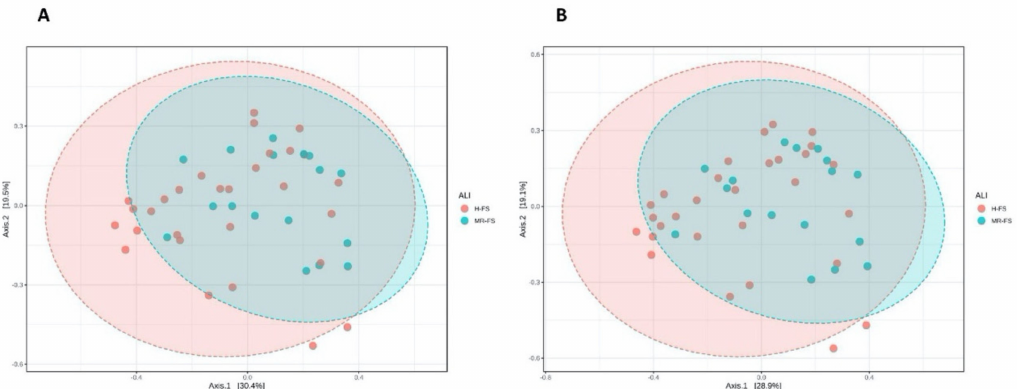
Figure 4. β -diversity plots calculated with PCoA distance matrix and Bray–Curtis index at the family ( A ) and genus ( B )